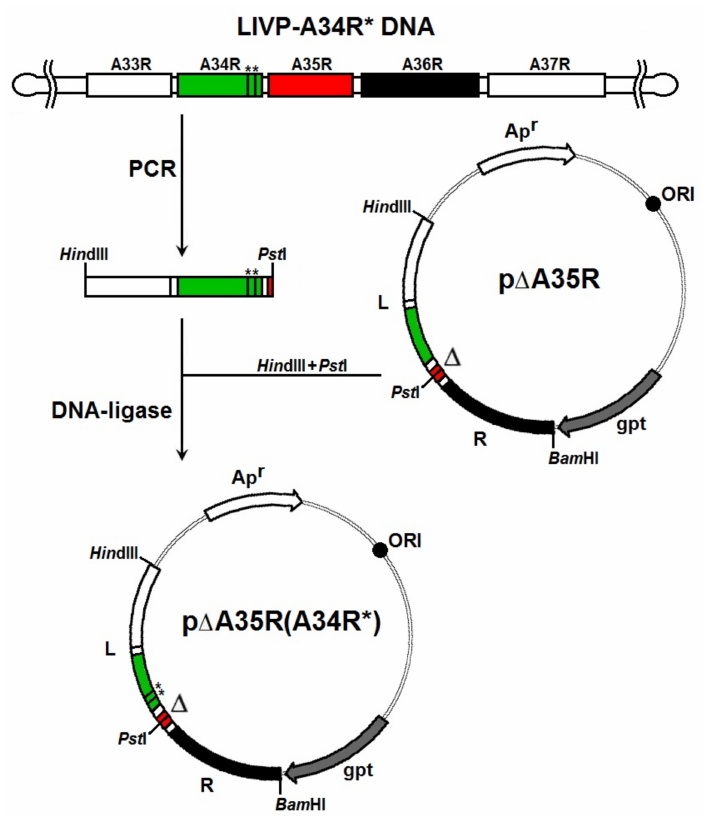
Figure 1. Scheme of construction of the plasmid p ∆ A35R(A34R*) (see explanation in the text). Vertical lines and asterisks indicate point mutations in A34R gene. L and R—left and right flanking A35R gene regions (**, Vertical lines and asterisks indicate point mutations in A34R gene